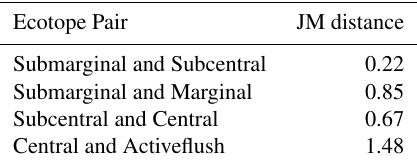
Table 3. JM distance between ecotopes Ecotope